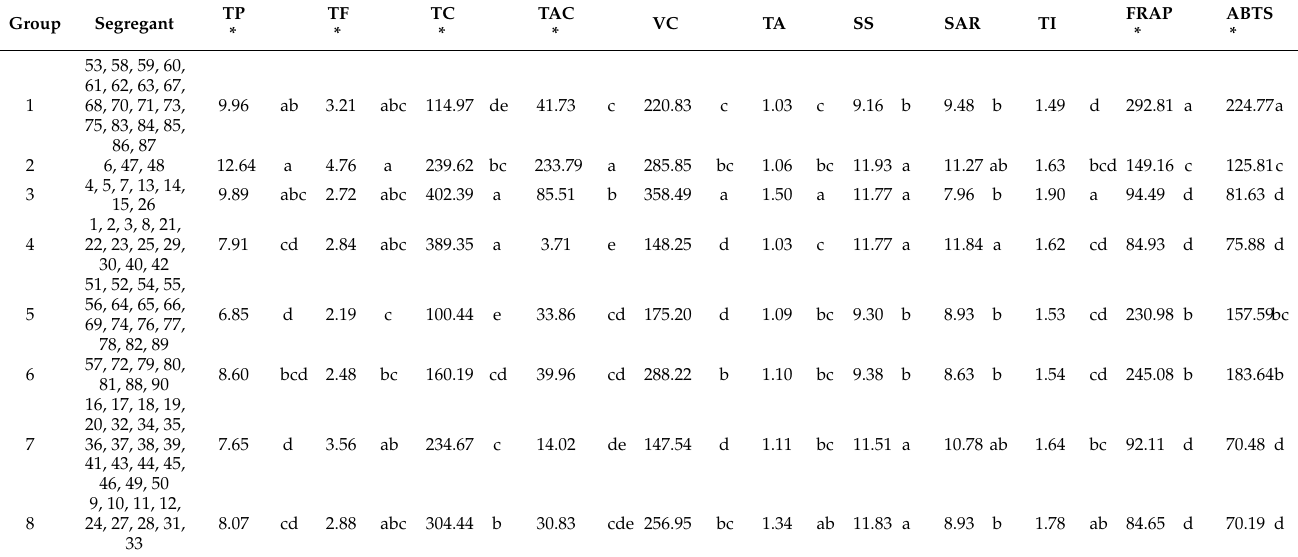
Table 6. Analysis of variance of the grouping criteria by antioxidant